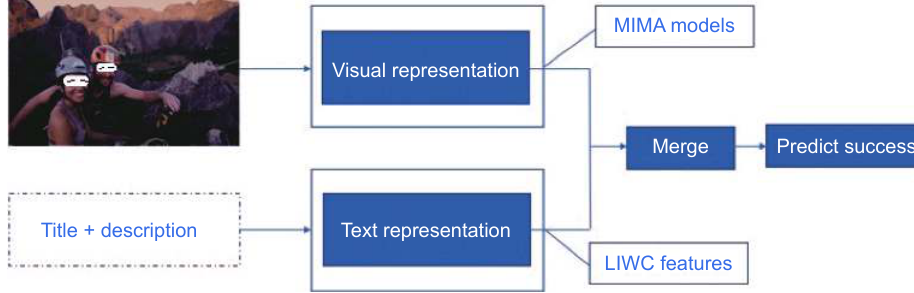
Fig. 7 Flowchart of the data